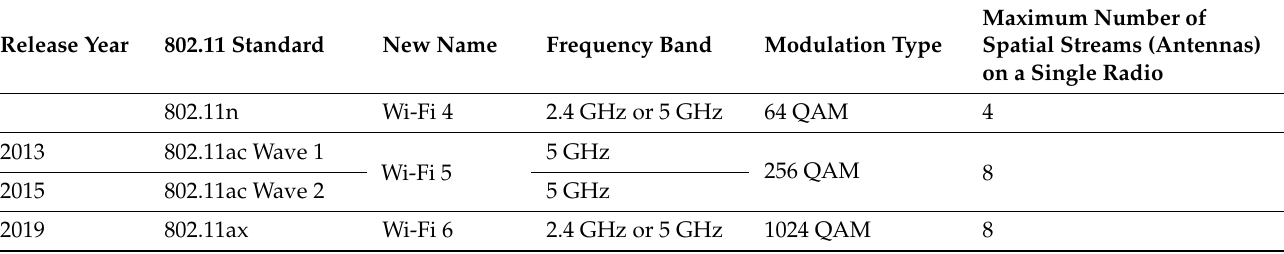
Table 1. WFA (Wi-Fi Alliance) Wi-Fi standards with